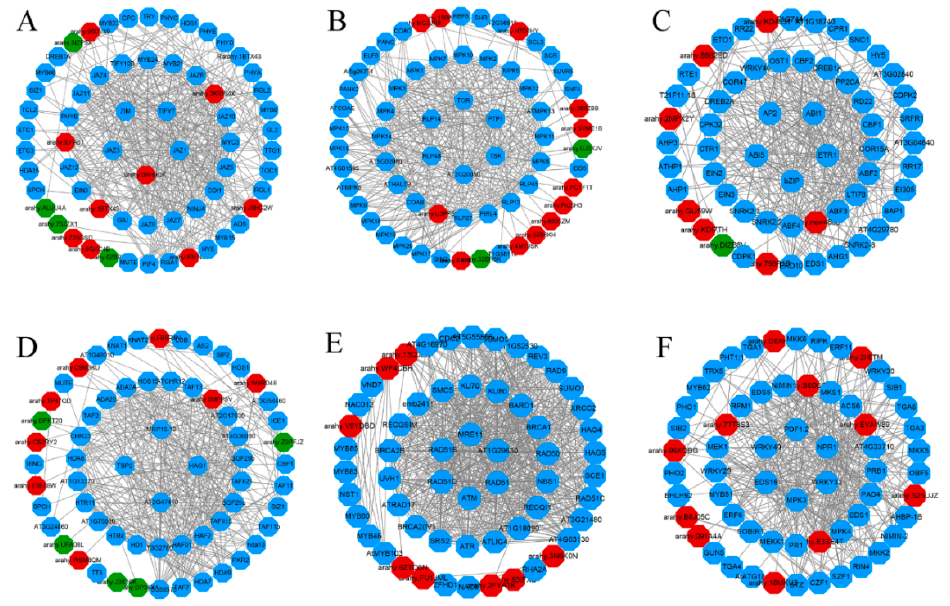
Figure 7. Protein–protein interaction (PPI) Network analysis of peanut transcription factors (TFs) in Clusters of Orthologous Group (COG) mode using STRING 11.0 database showing all connections of TF genes with a confidence score>0.4. Red nodes, upregulated TF genes; green nodes, downregulated TF genes; blue nodes, predicted genes interacting with peanut TFs. ( A ) bHLH (basic helix—loop—helix protein), ( B ) C2H2 (Cys2 / His2 zinc finger protein), ( C ) ERF (ethylene-responsive factor), ( D ) MYB (v-myb avian myeloblastosis viral oncogene homolog), ( E ) NAC (NAM, ATAF1 / 2, CUC2), and ( F ) WRKY.